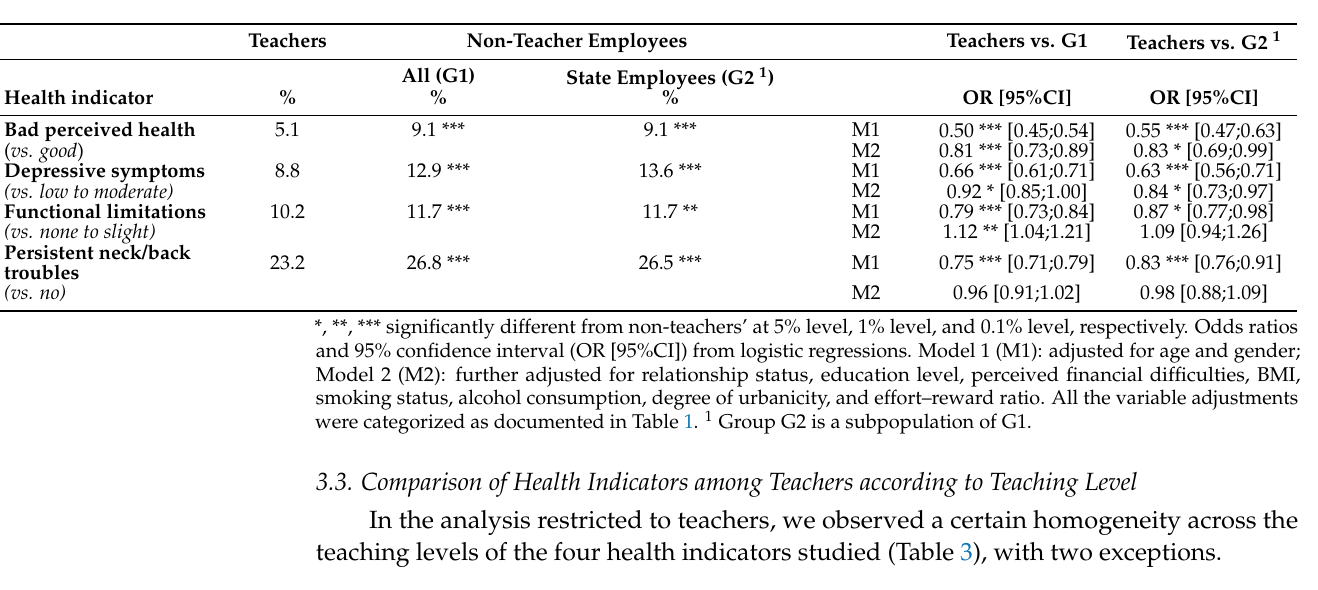
Table 2. Health indicators of teachers compared to all non-teacher employees and to other State employees, basic and further adjustment, ESTER-CONSTANCES study.